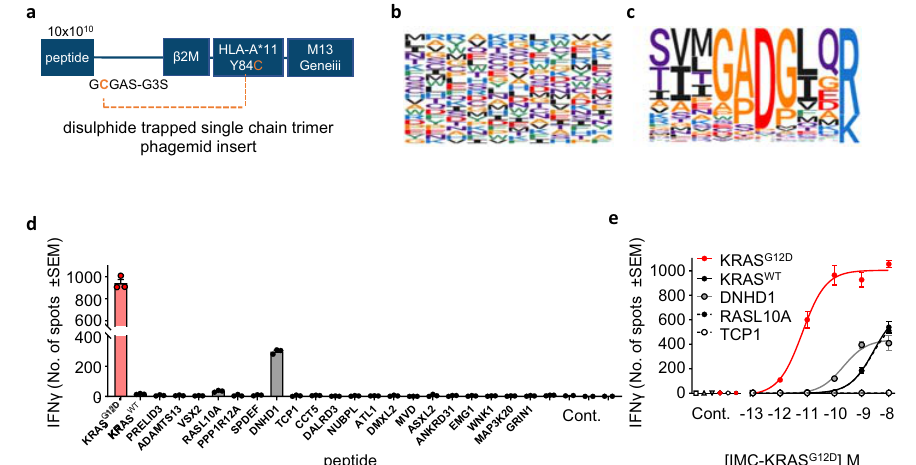
Fig. 4 | Peptide library screening shows that high af fi nity TCR JDIa96b35 has strong preference for D6 residue of HLA-A*11-KRAS G12D . a Schematic repre- sentation of the disuphide trapped single chain pHLA trimer construct. b The amino acid composition of the fully randomized peptide library. c Peptide speci- fi city pro fi le generated from the 452 peptides with n >1 following three cycles of panning with the TCR JDIa96b35. d IFN γ ELISPOT output after SUP-B15 cells were pulsed with 10 µ M indicated peptide, treated with 100pM IMC-KRAS G12D and co- cultured with PBMC for 24h. Targets alone, PBMC alone, no IMC-KRAS G12D , and no peptide negative controls (Cont.) were performed. Mean data of three biological